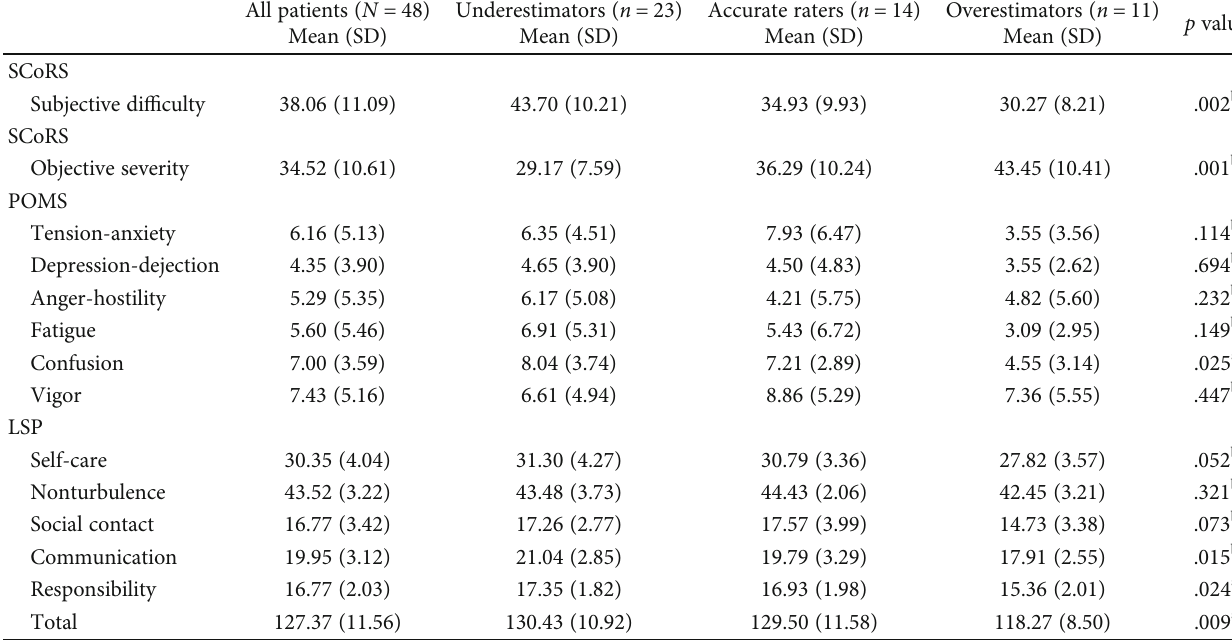
Table 2: Mean scores and SD for each rating scale and comparison between the three groups. All patients ( N = 48